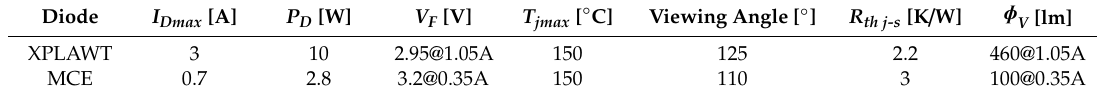
Table 1. The values of the operating parameters of the tested LEDs.